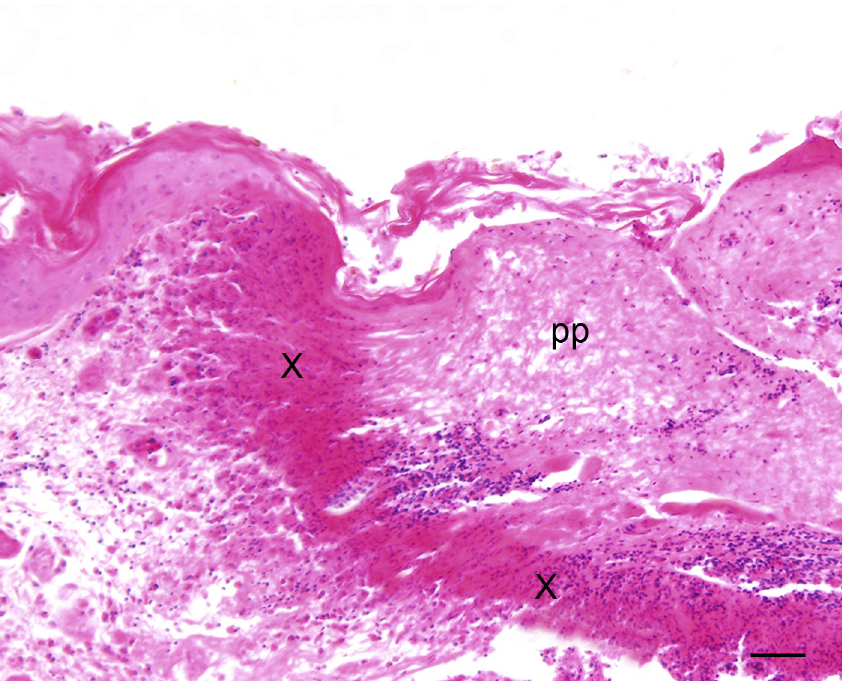
Fig 3. Pheasant chick with severe ulcerative dermatitis of the skin of the head with accumulation of cellular debris (X) and proteinaceous exudate (pp); HE, bar = 120 μ m. https://doi.org/10.1371/journal.pone.0234044.g003 ac2 and in three chicks (9%) in ac3. Numerous lungs showed acute haemorrhages. The kidneys displayed focally mild interstitial infiltrations consisting mainly of lymphocytes and macro- phages in two chicks (13%) in ac2 and five chicks (16%) in ac3. Independent of the age class, a mostly moderate diffuse infiltration with plasma cells was observed in almost all examined lac- rimal glands. Miscellaneous findings included focally mild lymphocytic myocarditis in one chick (3%) in ac3 (Fig 6), focally moderate lymphohistiocytic perineuritis ( N . ischiadicus ) in one chick in both ac2 (19%) and ac3 (3%), severe subacute hyaline degeneration of skeletal muscles with histiocytic infiltration in one chick (3%) in ac3, focal chronic suppurative